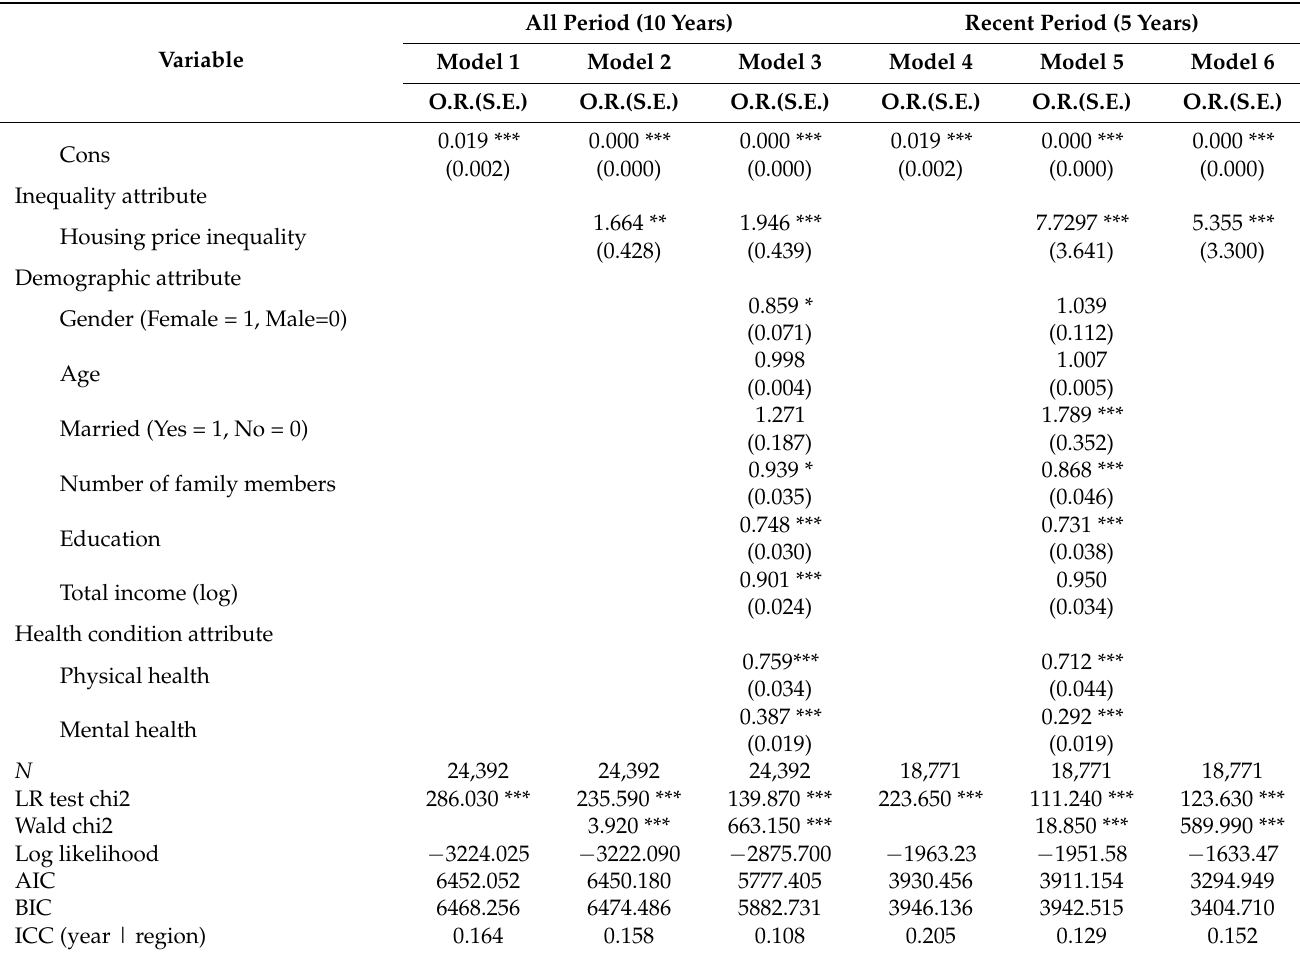
Table 2. Results for regression analysis between suicidal impulse and housing price inequality. All Period (10 Variable